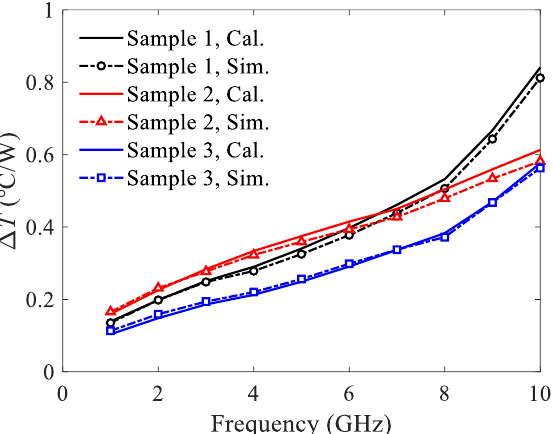
Figure 8. Temperature rises per watt of the U-shaped corrugated SWTLs.